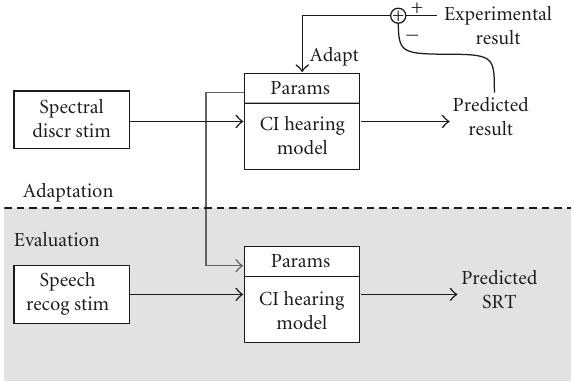
Figure 6: Adaptation and prediction procedure. The parameters of the CI model are adapted to match a set of experimental results, in this case the spectral discrimination thresholds. The adapted parameters are then used in a simulated speech recognition test.